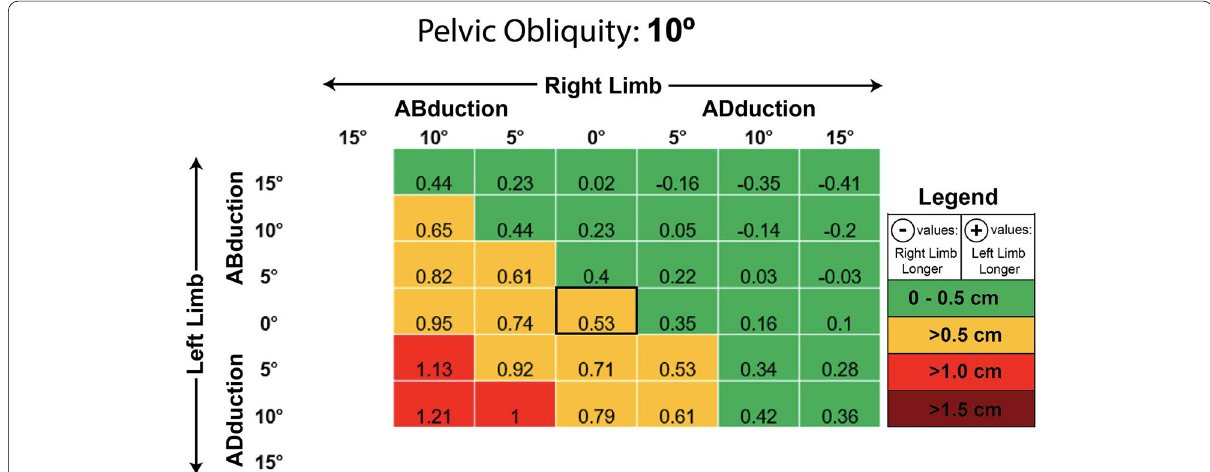
Fig. 6 Measurement error in centimeters seen at varying limb positions when the pelvic is set to 10 degrees of lateral obliquity